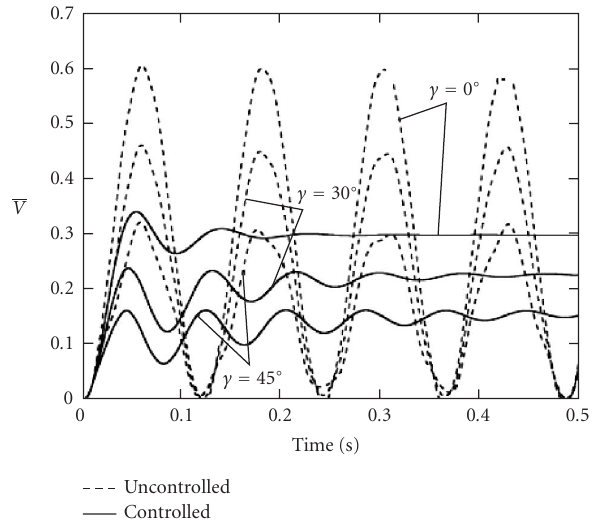
Figure 21: Influence of the presetting angle on uncontrolled/con- trolled nondimensional flapping deflection time-history of the blade subjected to the step loading with σ = 1, β o = 0, Ω = 0, and θ =